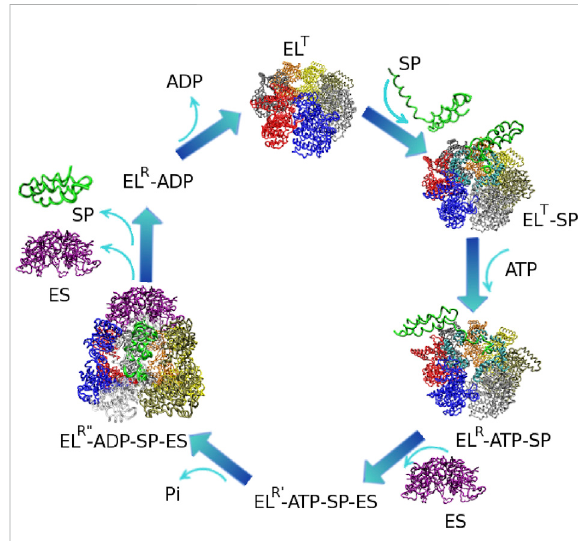
FIGURE 2 ReactionhemicycleofGroELillustratingthesubstrateprotein (SP) folding assistance. EL and ES stand for GroEL and GroES respectively. The GroEL T state has a high af fi nity for SP binding. Upon ATP and GroES binding, the SP is displaced into the expanded GroEL cavity, where productive folding can take place. Dissociation of the complex occurs upon the initiation of a folding reaction in the opposite GroEL ring. The structures of the T, R, and R ″ states are known. Reproduced from (Stan et al., 2007) Ⓒ (2007) National Academy of